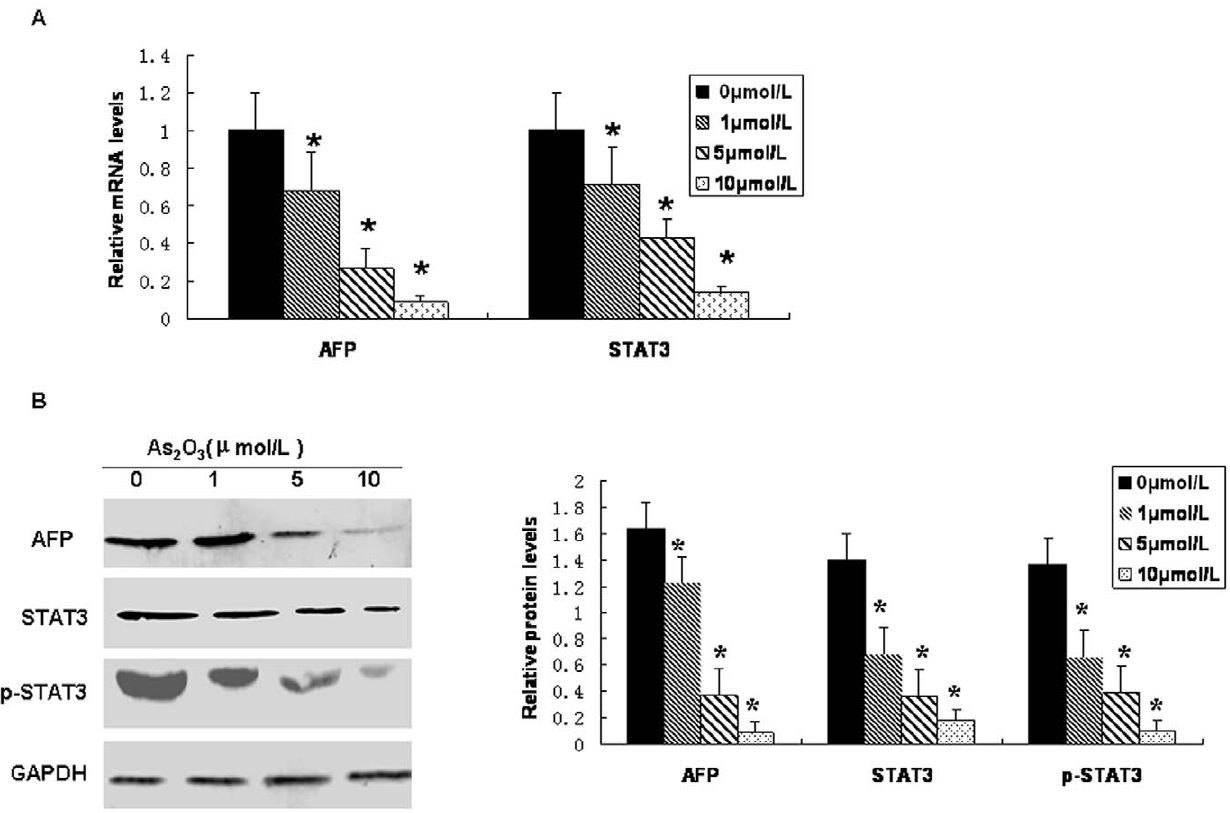
Figure 2. As2O3 downregulates AFP, STAT3, and phospho-STAT3 expression in FU97 cells. Cells were exposed to As2O3 at 5 m mol/L for 72 h. (A) Quantitative RT-PCR of mRNA expression. (B) Western blot analysis and quantification of protein expression. Data are representative of 3 independent experiments with similar results. *p , 0.05 compared with 0 m mol/L.